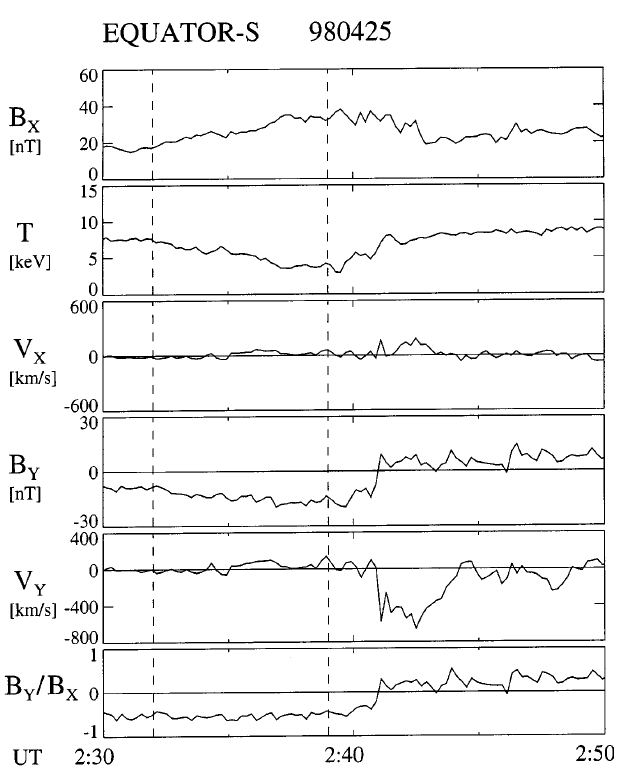
Fig. 8. Magnetic field and plasma moments between 0230 and 0250 UT for Equator-S in near-field-aligned coordinates (see text). The flows shown in the figure are components perpendicular to the field